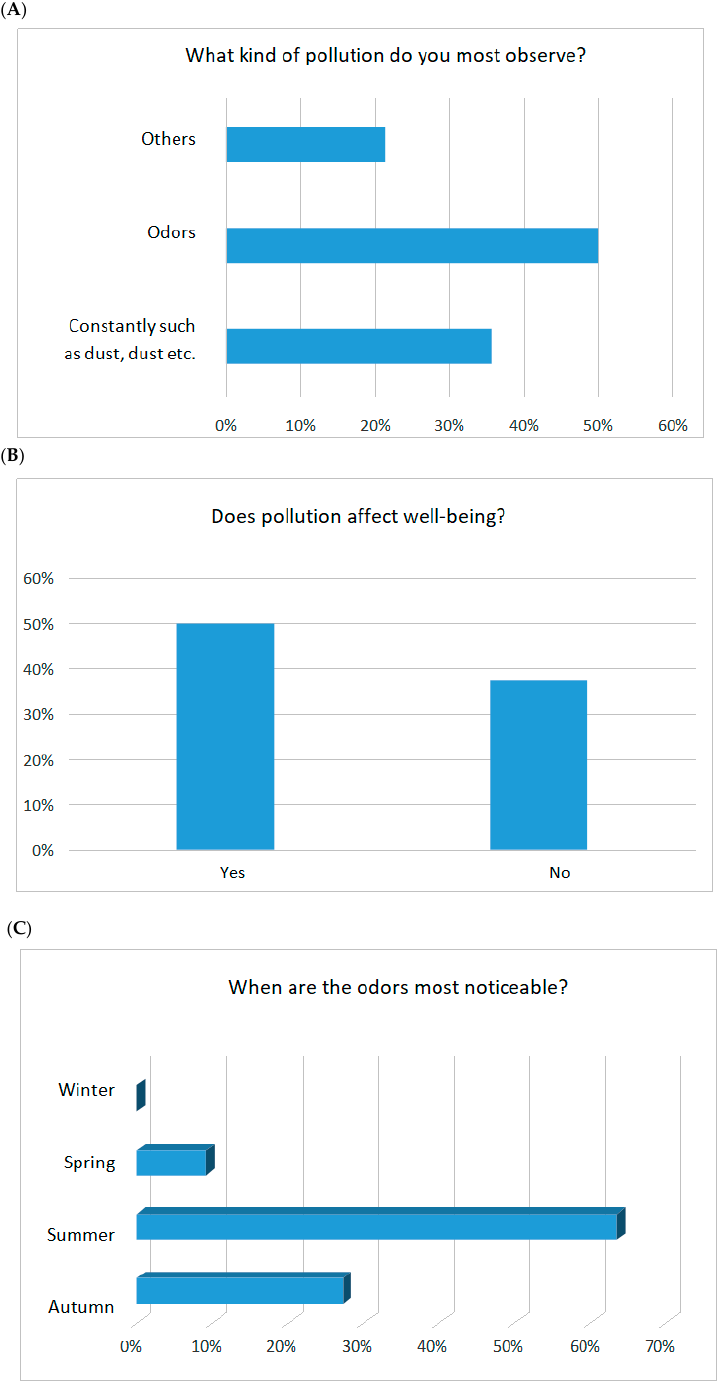
Figure 3. Selected statistics of the respondents’ answers to survey questions from residents neigh- boring with commercial hen houses. ( A ) What kind of pollution do you most observe? ( B ) Does pollution affect well-being? ( C ) What are the odors most